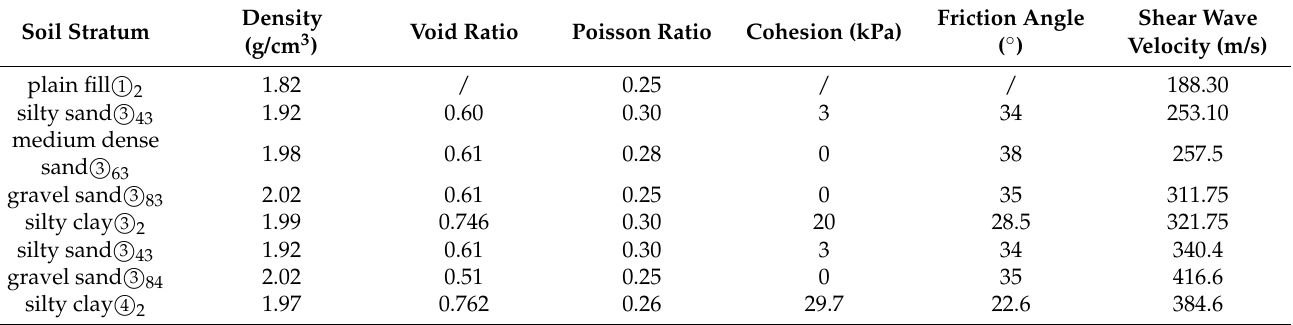
Table 2. Soil mechanics